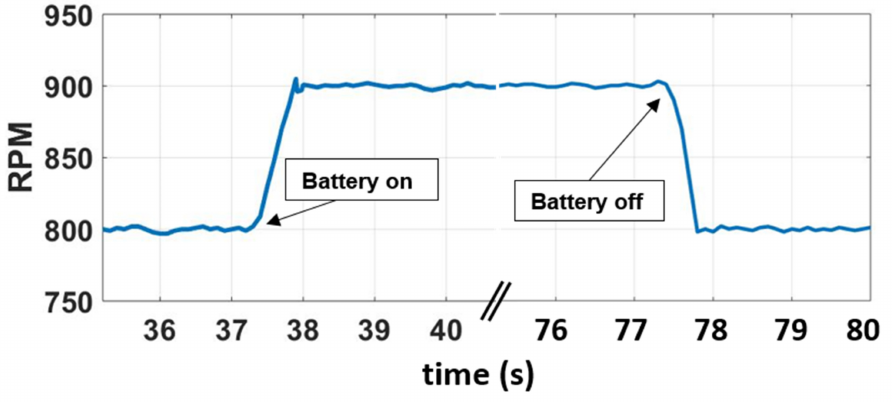
Figure 12. Motor speed with battery